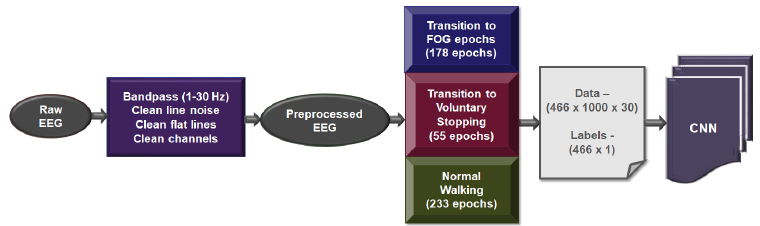
Figure 2. EEG preprocessing and feature extraction for DL